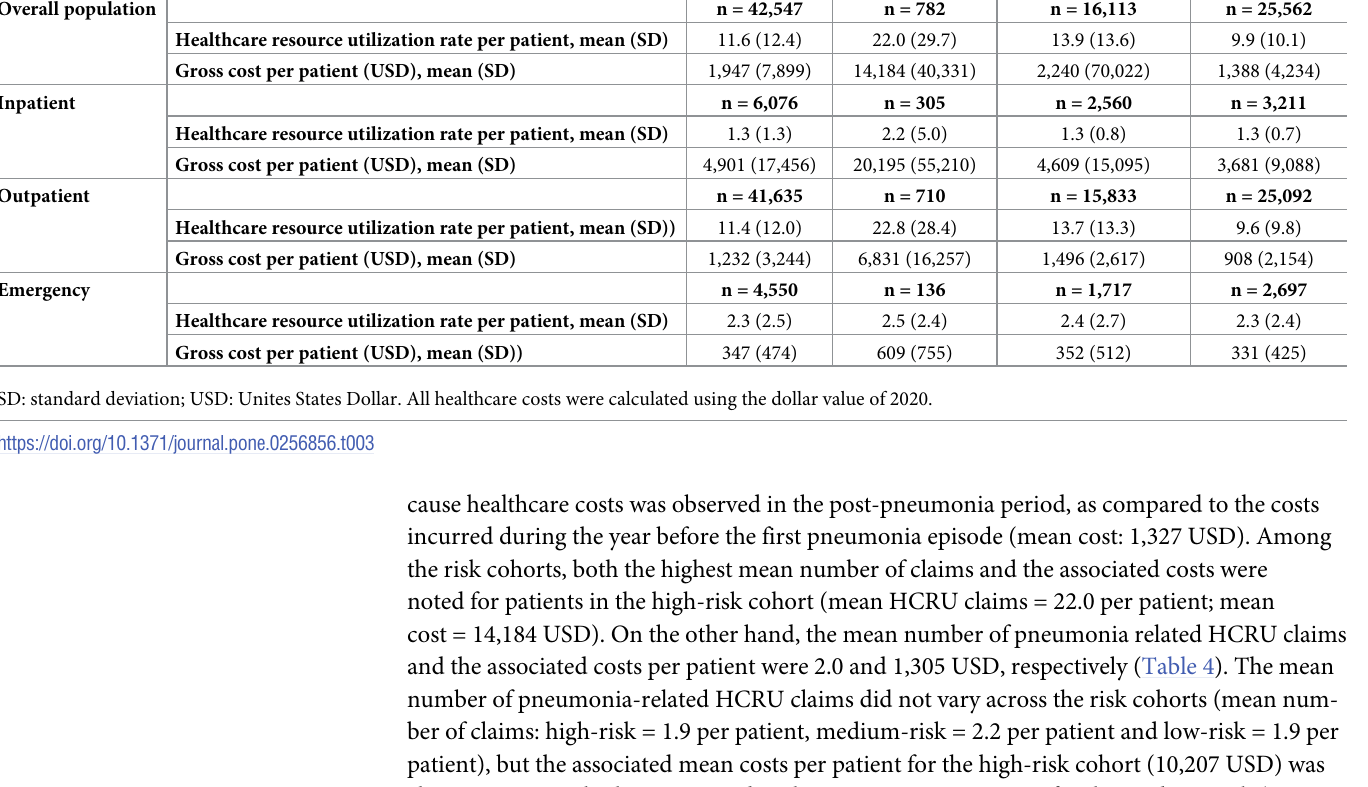
Table 3. Healthcare resource utilization and healthcare cost per patient (all-cause claims) during 12-month follow-up (patients having at least one claim for pneu- monia during 12-month follow-up period were included in the analysis; Dubai Real-World Claims Database, 2014 to 2019). Overall Cohort High-risk Cohort Medium-risk Cohort Low-risk Cohort